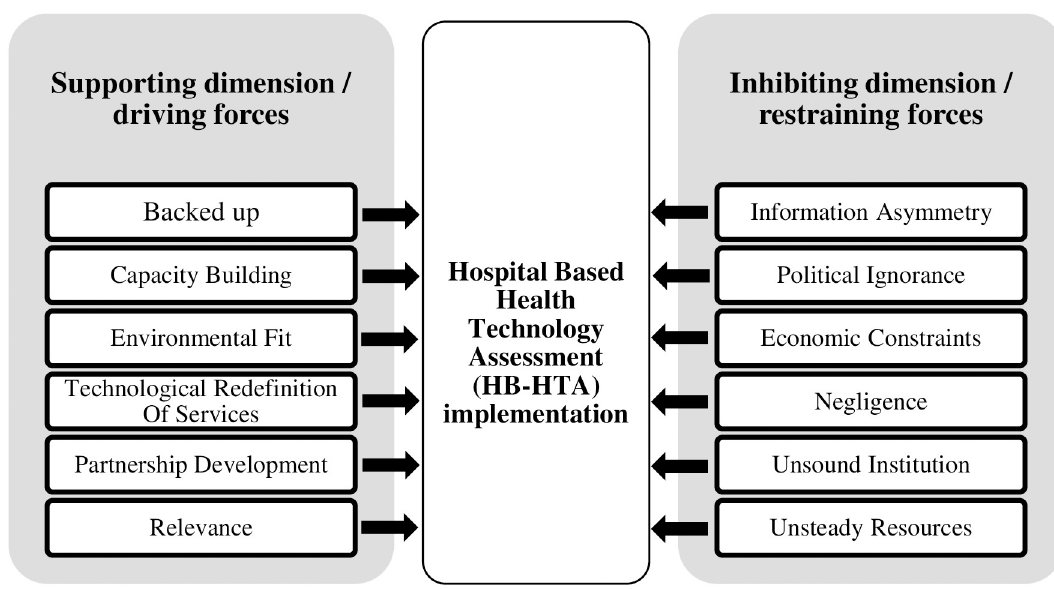
Fig 3. Model of dimensions supporting and inhibiting the HB-HTA